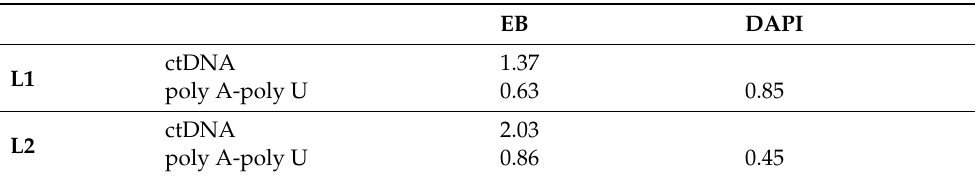
Table 1. IC 50 values determined for the displacement of EB and DAPI from ctDNA and poly A-poly U by addition of L1 and L2 (NaCac 50 mM, pH